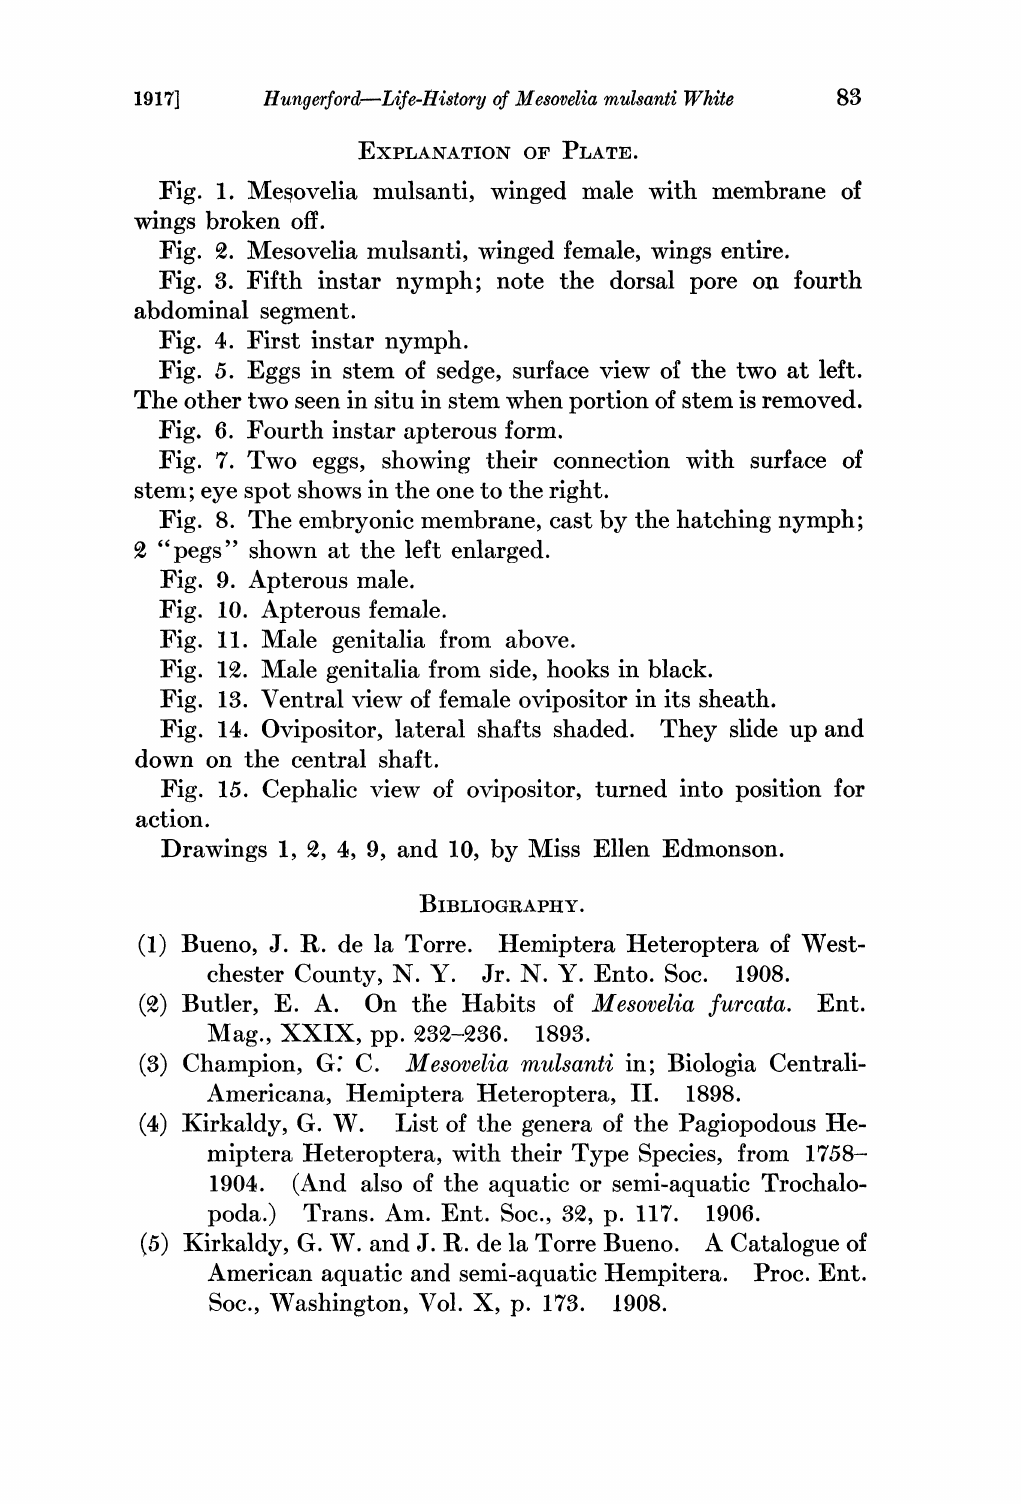
. Fig. 1. M:esovelia mulsanti, winged male with membrane of wings broken off. Fig. Fig. 3. Fifth instar nymph; note the dorsal pore on fourth abdominal segment. Fig. 4. First instar nymph. Fig. 5. Eggs in stem of sedge, surface view of the two at left. The other two seen in situ in stem when portion of stem is removed. Fig. 6. Fourth instar apterous form. Fig. 7. Two eggs, showing their connection with surface of stem; eye spot shows in the one to the right. Fig. 8. The embryonic membrane, cast by the hatching nymph; "pegs" shown at the left enlarged. Fig. 9. Apterous male. Fig. 10. Apterous female. Fig. 11. Male genitalia from above. Fig. 1. Male genitalia from side, hooks in black. Fig. 13. Ventral view of female ovipositor in its sheath. Fig. 14. Ovipositor, lateral shafts shaded. They slide up and down on the central shaft. Fig. 15. Cephalic view of ovipositor, turned into position for